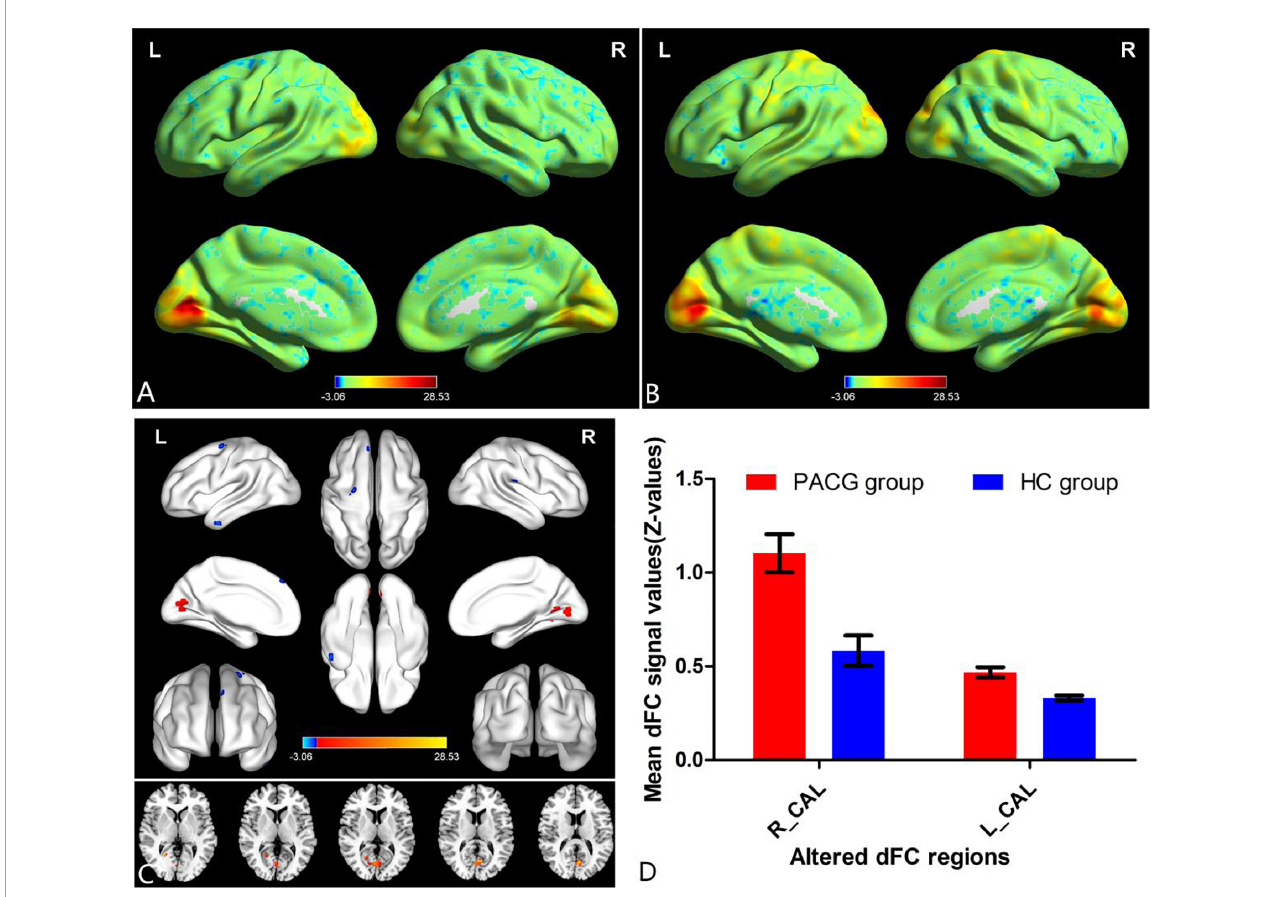
FIGURE1 One-sample t -test results of dynamic functional connectivity (dFC) in left V1 maps within primary angle-closure glaucoma (PACG) group (A) and HC group (B) ; significant dFC differences in left V1 between two groups (C) ; the mean of altered dFC values of left V1 between the patients with PACG and HCs (D) . PACG, primary angle-closure glaucoma; HC, health control; V1, primary visual cortex; dFC, dynamic functional connectivity; CAL, calcarine; R, right; L,